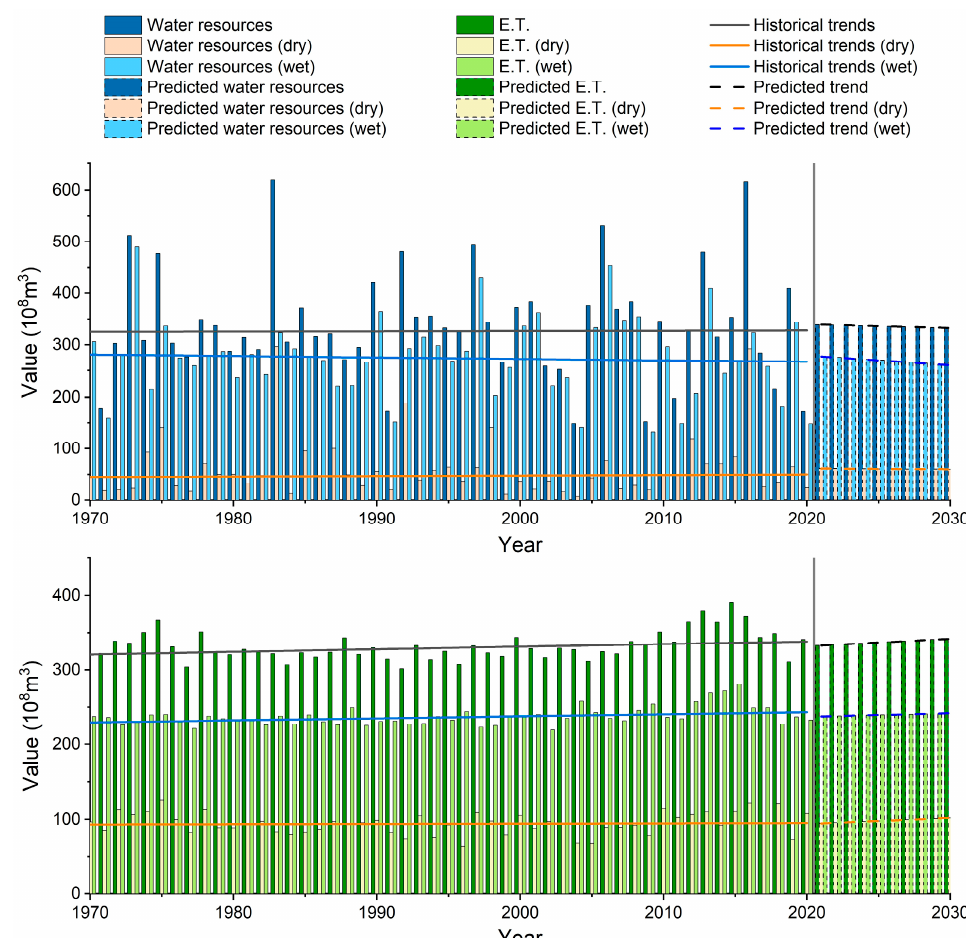
Figure 5. Forecast of water resources and E.T. in the Hanjiang River Basin for the next 10